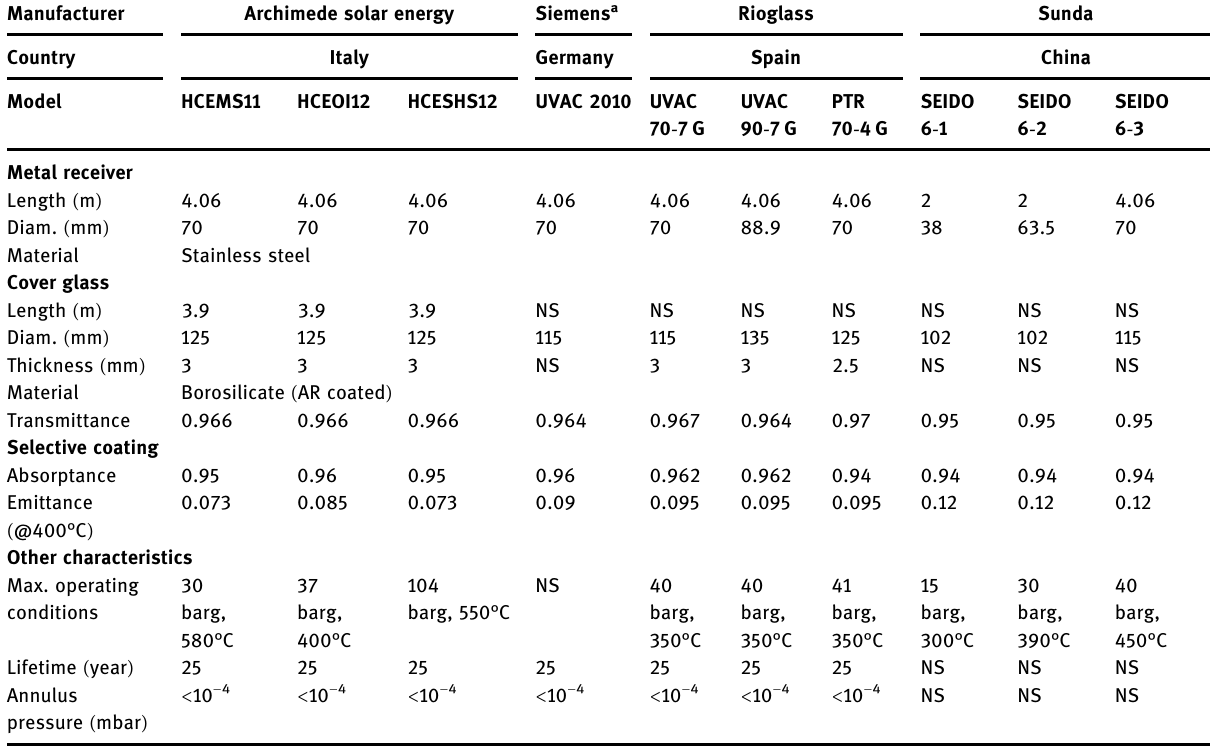
Table 5: Characteristics of some prefabricated receivers [ 51 – 57